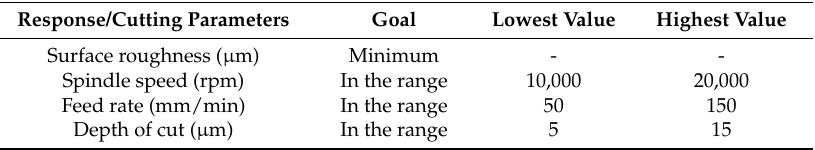
Table 6. Goals and ranges assigned to the response and cutting parameters.